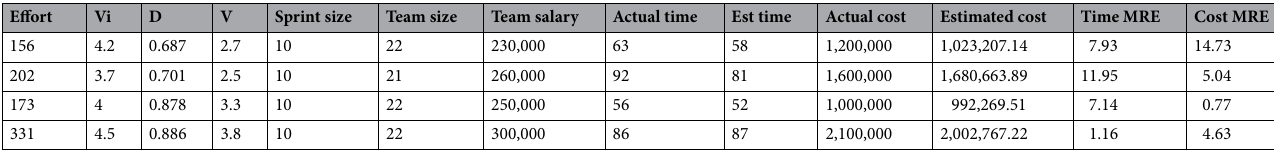
Table 2. Dataset sample. In the sample dataset, there are 13 fields discussed below. Each row represents an agile Project. Projects names are not revealed in the referred dataset. The Effort represents Number of Story Points. V i is Initial Team Velocity. D is Deceleration, which affects the Team Velocity. V is the Final adjusted team velocity, calculated by V = (V i ) D . Sprint Size is the size of a typical Sprint in a Scrum Project. Team Size is the size of Scrum Team. Team Salary is the salary of Scrum Team Members. Actual Time field value represents Number of Days, for instance, in first row 156 Story Points (SP) took 63 days to complete Est. Time is the value of the estimated time calculated by Zia 21 in his paper. Actual Cost is the cost of Scrum Project. Estimated Cost is the estimated calculated by Zia. Time MRE is the value of Magnitude of Relative Error calculated by MRE(Time) = (Actual Time − Est. Time)/Actual time. Cost MRE is calculated by MRE(Cost) = (Actual Cost − Estimated Cost)/Actual